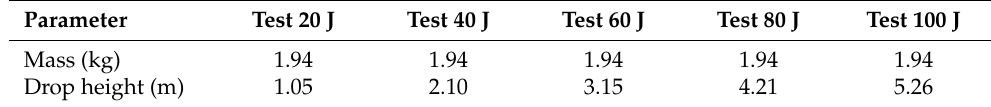
Figure 3. Overview of the new experimental methodology for studying mouthguard impacts at high impact energies, detailing ( a ) the dimensions of the mouthguard including the manufactured mouthguard and mouthguard fixture, ( b ) demonstrating the experimental setup including camera position and high-speed imaging for analysis, and ( c ) showing the mechanical approach used to analyse the hockey ball mouthguard impact using a 2DOF mass-spring-damper model based on high-speed imaging. Table 4. Overview of experiments specifications to obtain the different impact